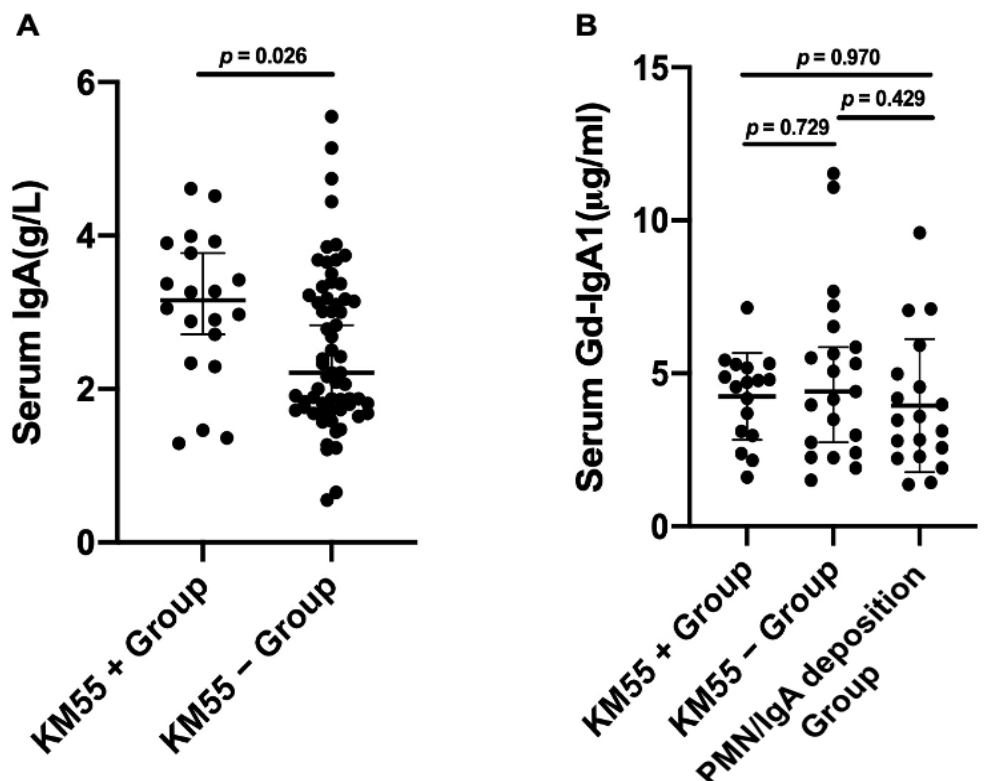
Figure 4. Comparison of the level of serum IgA(A) and Gd-IgA1(B) between KM55+ and KM55 − subgroup in PMN/IgAN patients. (A) The level of serum IgA in KM55+subgroup was higher than KM55 − subgroup in PMN/IgAN patients. (B) There was no significant difference in the level of se- rum Gd-IgA1 in KM55+ subgroup and KM55 − subgroup, similar to the PMN/IgA deposition group. Because the positive rates of tissue staining for PLA2R were significantly lower in the PMN/IgAN group, we performed other pathogenic antigens (e.g.,7A,NELL-1) for PLA2R- negative patients ( n = 20) to evaluate PMN antigen difference between KM55+ and KM55 − subgroups (Figure 5 and Table 6). Most of the KM55+ patients (85%) were PLA2R associ- ated MN, 10% were NELL-1 associated MN, and only 5% were unknown. The antigen of most of both KM55 − and PLA2R- patients was unknown.